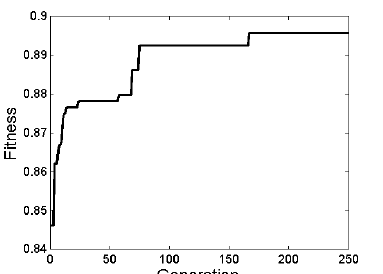
Figure 7. Convergence